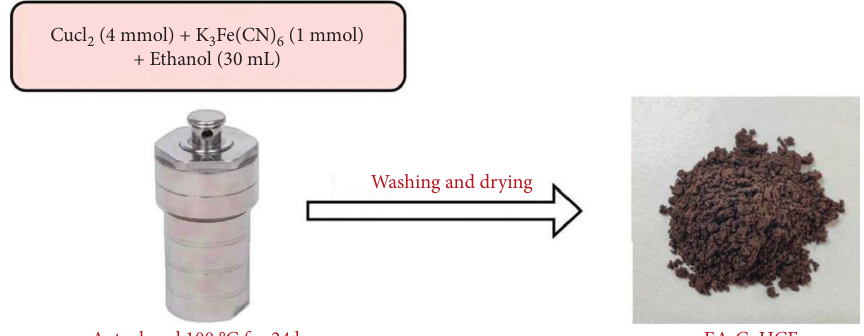
Figure 1: Diagram of the process of solvothermal synthesis of